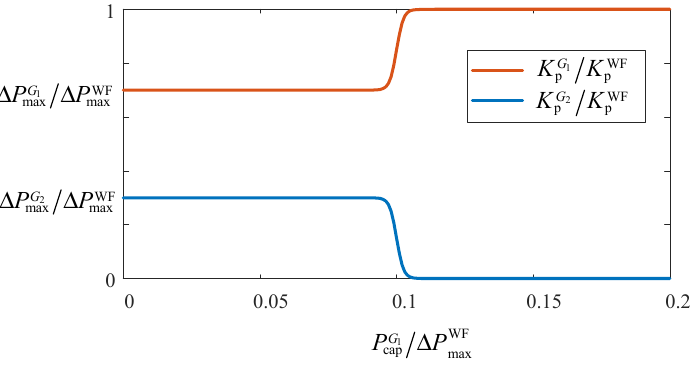
Figure 8. Exponential membership functions.